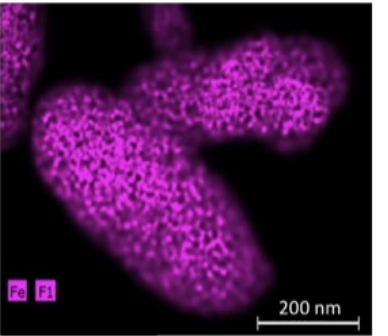
Figure 7. EDX maps of the P ( a ) and Fe ( b ) elements for the C-LiFePO multi-composite. (Reprinted with permission from [66]. Copyright 2012